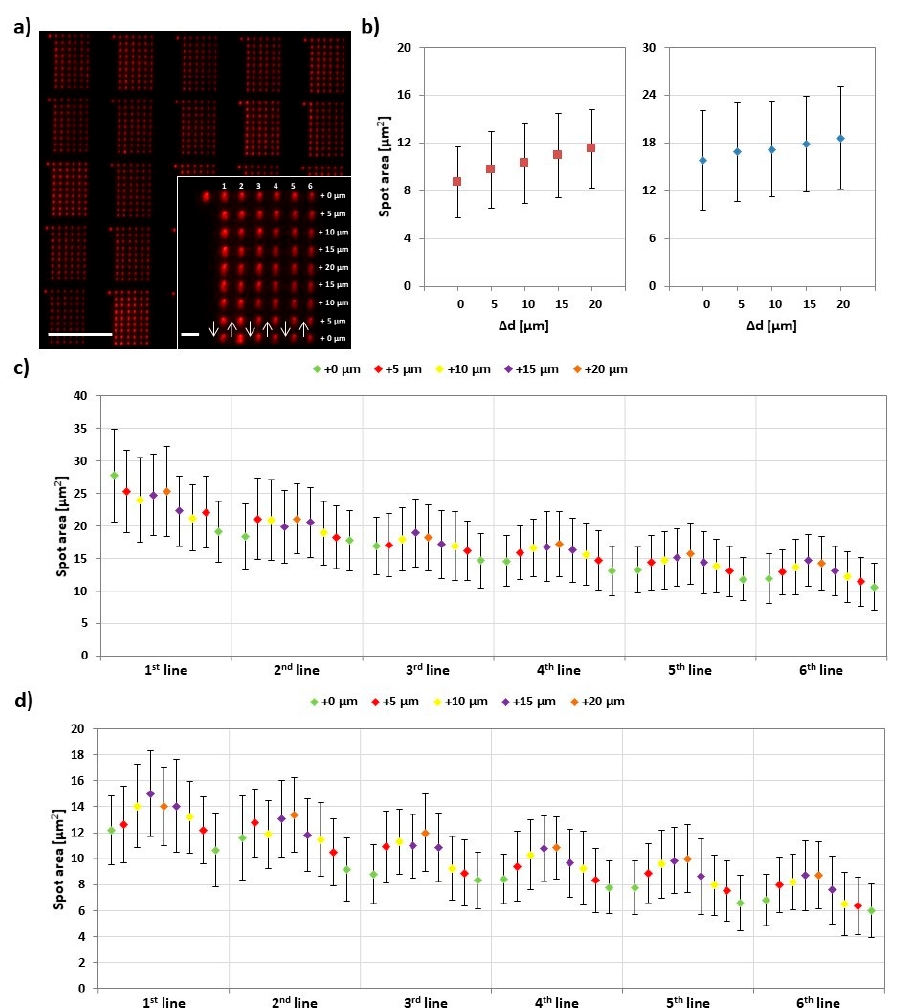
Figure 6. Effect of printing pressure on lipid ink transfer. ( a ) Representative fluorescence micrograph of the printed 9 × 6 arrays designed to analyze the amount of transferred lipid in dependence of relative pressure increase Δ d (i.e., increase in stage advancement (d). The inset shows higher magnification of a single array along with the printing scheme. The scale bars equal 100 µm in the main image and 10 µm in the inset; ( b ) Plot of the average area against Δ d in two independent experiments. Equivalent plots for the average fluorescence intensities against Δ d in the two experiments are shown in Figure S8; ( c,d ) Plots of average area of corresponding spots (same line and same Δ d) against Δ d in 30 analyzed arrays in the two experiments. Error bars represent standard deviation.